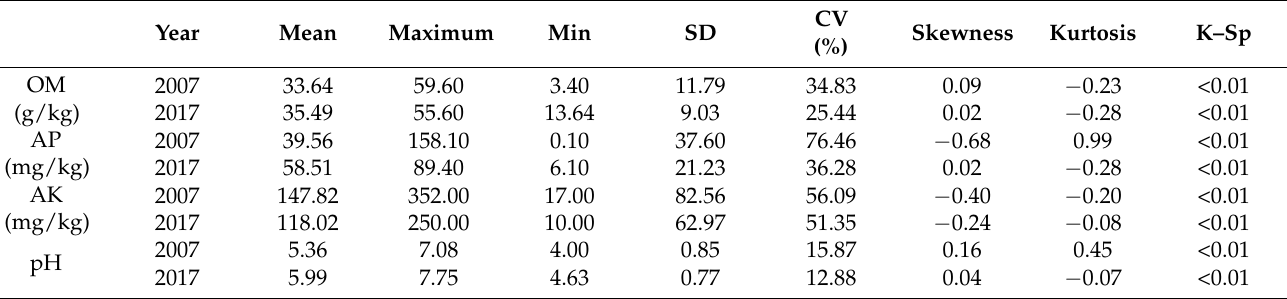
Table 3. Descriptive statistics of the soil indicators.